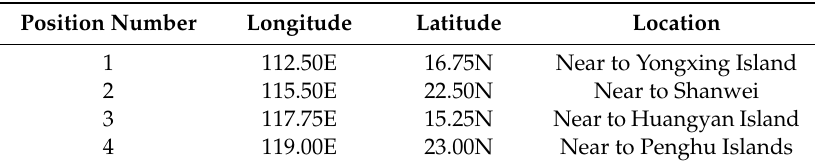
Table 1. Information on the selected sites.